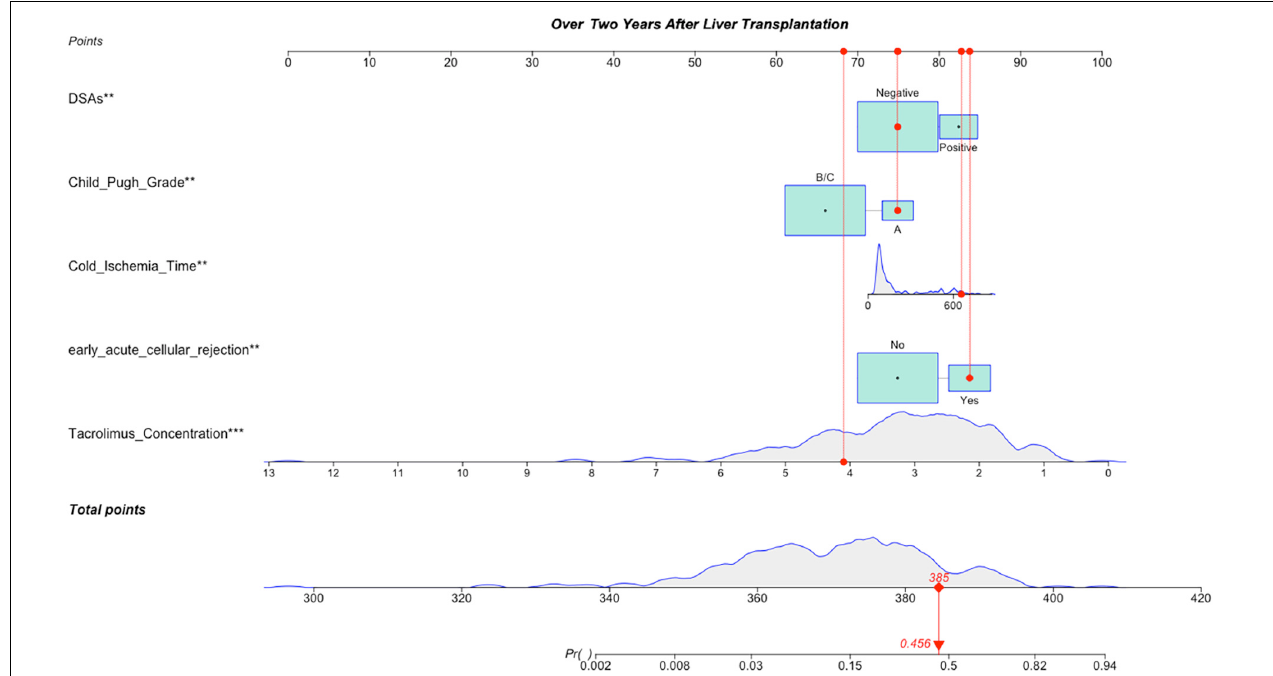
FIGURE 4 | A constructed nomogram for LACR prediction > 2 years after pLT. The “example” patient’s child-pugh grade was A, cold ischemia time was 657 min, DSAs were negative, early acute cellular rejection was yes and tacrolimus concentration over 2 years after transplantation was 4.1 ng/mL. Density plot of tacrolimus concentration, cold ischemia time and total points shows their distributions. For category variables, their distributions are reflected by the size of the box. The degree of influence was arranged from top to bottom. In order to use the nomogram, the specific points (red dots) of individual patients are located on each variable axis according to the clinical datum. The red dots of each variable are reflected upward on the Points axis; the sum of these points (385) is located on the Total Points axis, and a line is drawn down to the Probability axis to determine the probability of LACR. In this example, 0.456. LACR, late-onset acute cellular rejection; DSAs, donor-specific antibodies. * p -value < 0.05; ** p -value < 0.01; *** p -value <